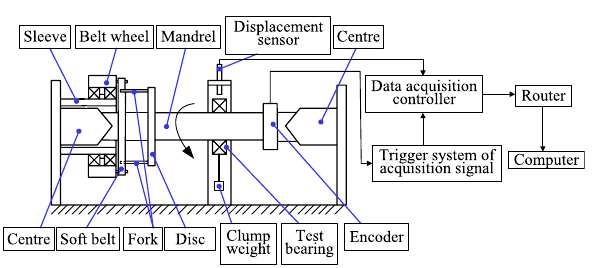
Figure 2. Schematic diagram to measure the radial run-out of the inner